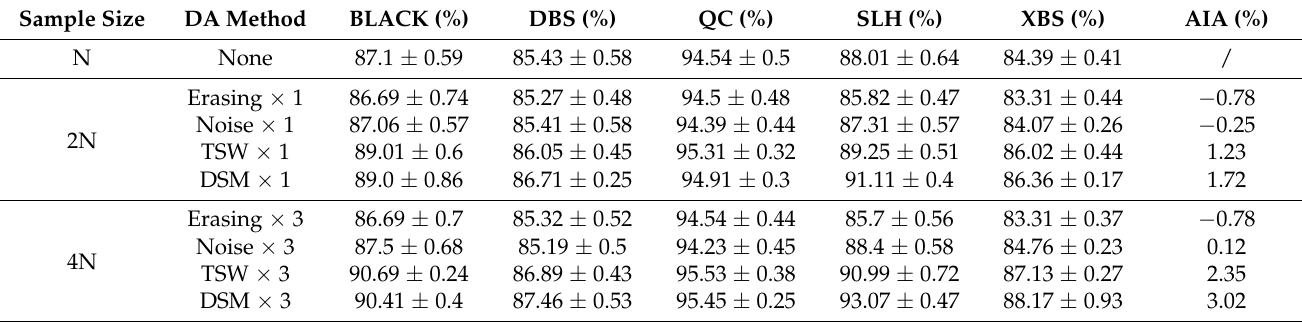
Table 6. Results of SVM training using all gradient data.